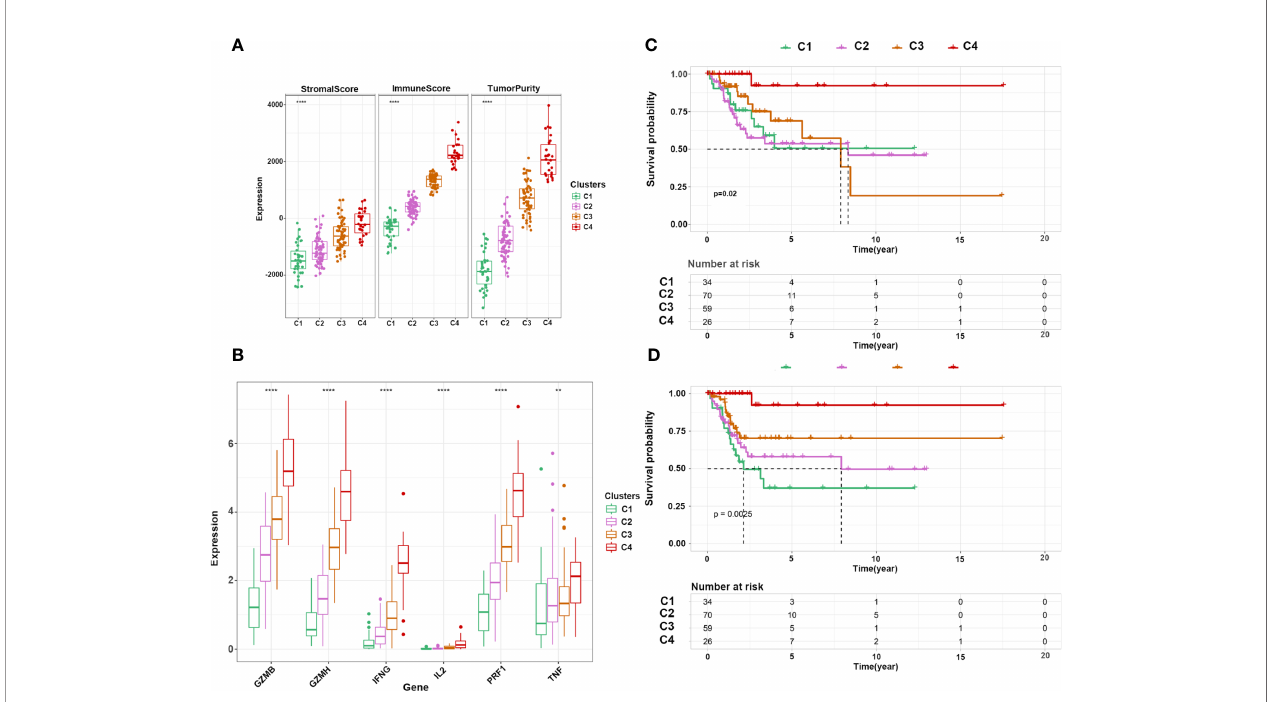
FIGURE 4 | Characterization of immune clusters of CC. (A) Expression of immune score, stromal score, and tumor purity in the four subtypes. (B) Expression of cytotoxicity-related cytokines in the four subtypes. (C, D) Kaplan – Meier curve shows the OS and PFI of 4 clusters. ** p ≤ 0.01, **** p ≤